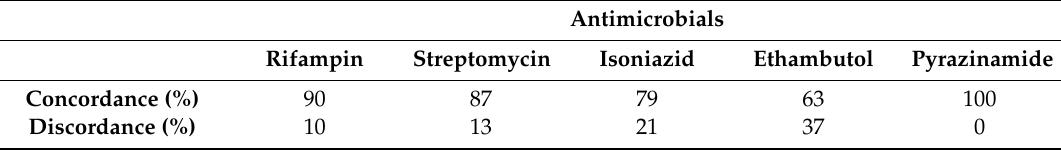
Table 3. Concordance and discordance of the MODS (direct and indirect) and BACTEC MGIT 960